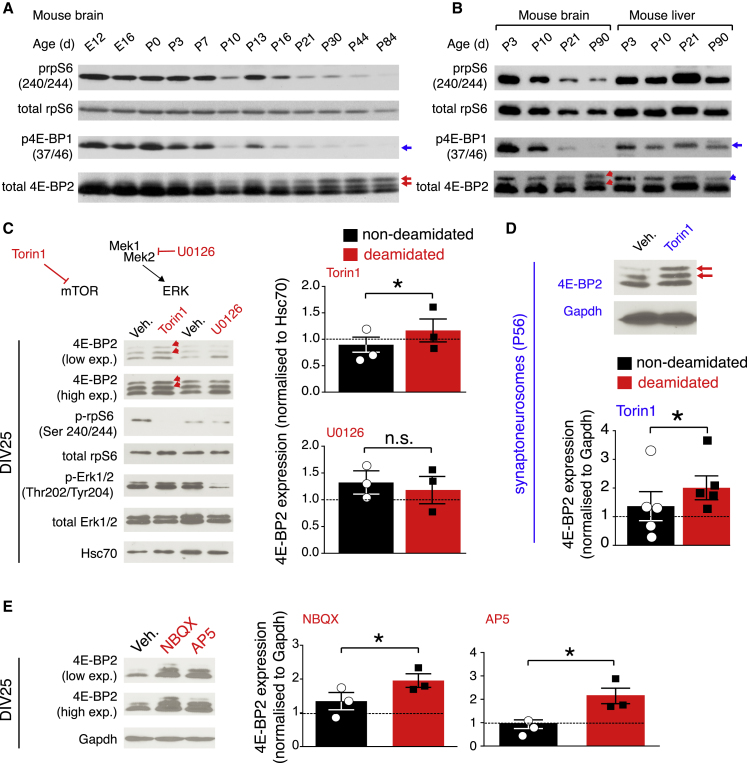
mTOR, AMPAR, or NMDAR Inhibition Promotes the Accumulation of Deamidated 4E-BP2(A) mTORC1 and 4E-BP2 deamidation in the brain. Immunoblotting of mouse forebrain lysates collected at different ages and probed with antisera against the indicated proteins.(B) mTORC1 and 4E-BP2 deamidation in the brain versus the liver.(C) Top left: diagrammatic depiction of pathways inhibited by Torin 1 and U0126 inhibitors. Bottom left: representative immunoblots from DIV25 neuron lysates treated with vehicle or 250 nM Torin 1, or vehicle or 20 μM U0126 for 9 h, probed with antisera against the indicated proteins; Hsc70 is a loading control. Right: quantification of immunoblots; 4E-BP2 expression normalized to control is shown for WT and deamidated (2D) 4E-BP2.(D) Top: representative immunoblots from P56 mouse brain-extracted synaptoneurosomes treated with vehicle or 250 nM Torin 1 for 1 h, probed with antisera against the indicated proteins. Bottom: quantification of immunoblots; 4E-BP2 expression normalized to control is shown for WT and deamidated (2D) 4E-BP2.(E) Representative immunoblots (left) and quantification of 4E-BP2 expression normalized to control (right) from DIV25 neuron lysates treated with vehicle, 10 μM NBQX, or 50 μM AP5 for 9 h, probed with antisera against the indicated proteins. GAPDH is the loading control.For (A) and (B), the blue arrows show the phosphorylation of 4E-BP2, while the red arrows mark the slower migrating forms of deamidated (single or double) 4E-BP2 protein.For (C)–(E), the data are shown as means ± SEMs (error bars). For (C) and (E), n = 3 per condition. For (D), n = 5 per condition. The intensity of the vehicle band is set as 1 (dotted line on graph). Two-way ANOVA; Bonferroni’s post hoc; ∗p < 0.05, ∗∗p < 0.01.See also Figures S4 and S5 and Table S2.